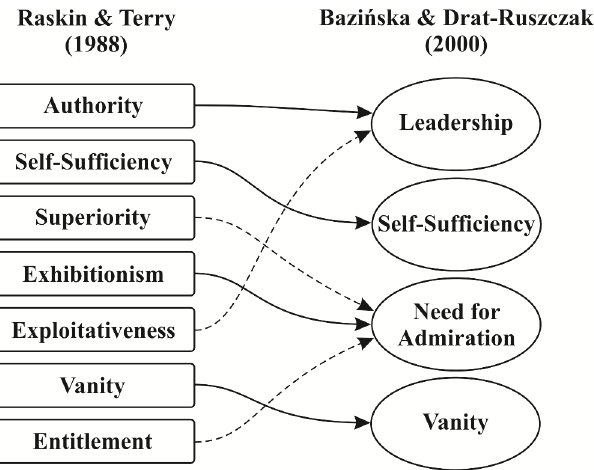
Fig 1. Items included in the original version and Polish adaptation of Narcissistic Personality Inventory (dashed arrow means modification of a scale).